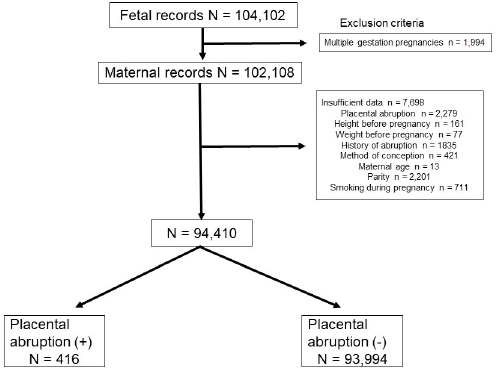
Fig 1. Flowchart for enrolment and inclusion of participants in the